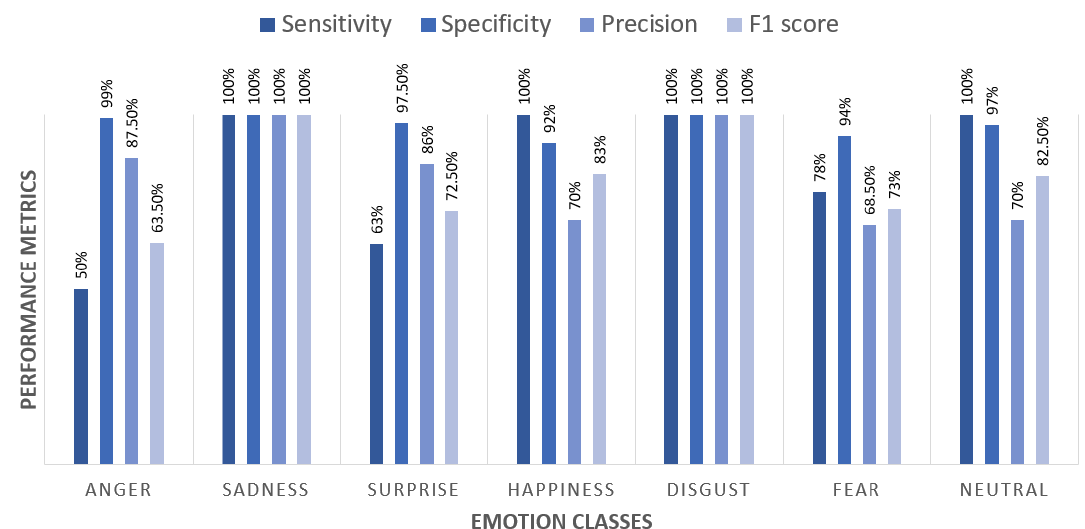
Figure 4. Comparison of the sensitivity, specificity, precision and F1 score metrics computed for the single emotion classes when considering the best combination of DA techniques, i.e., GAN, HR and TR. Training database, KDEF; testing database,